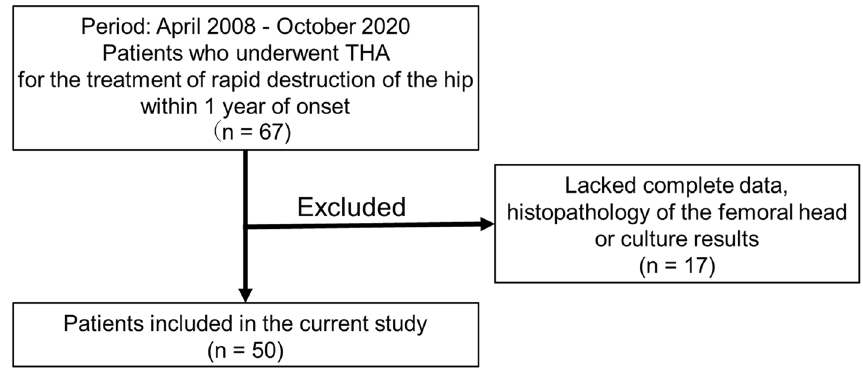
Figure 1. Study flowchart of all cases.